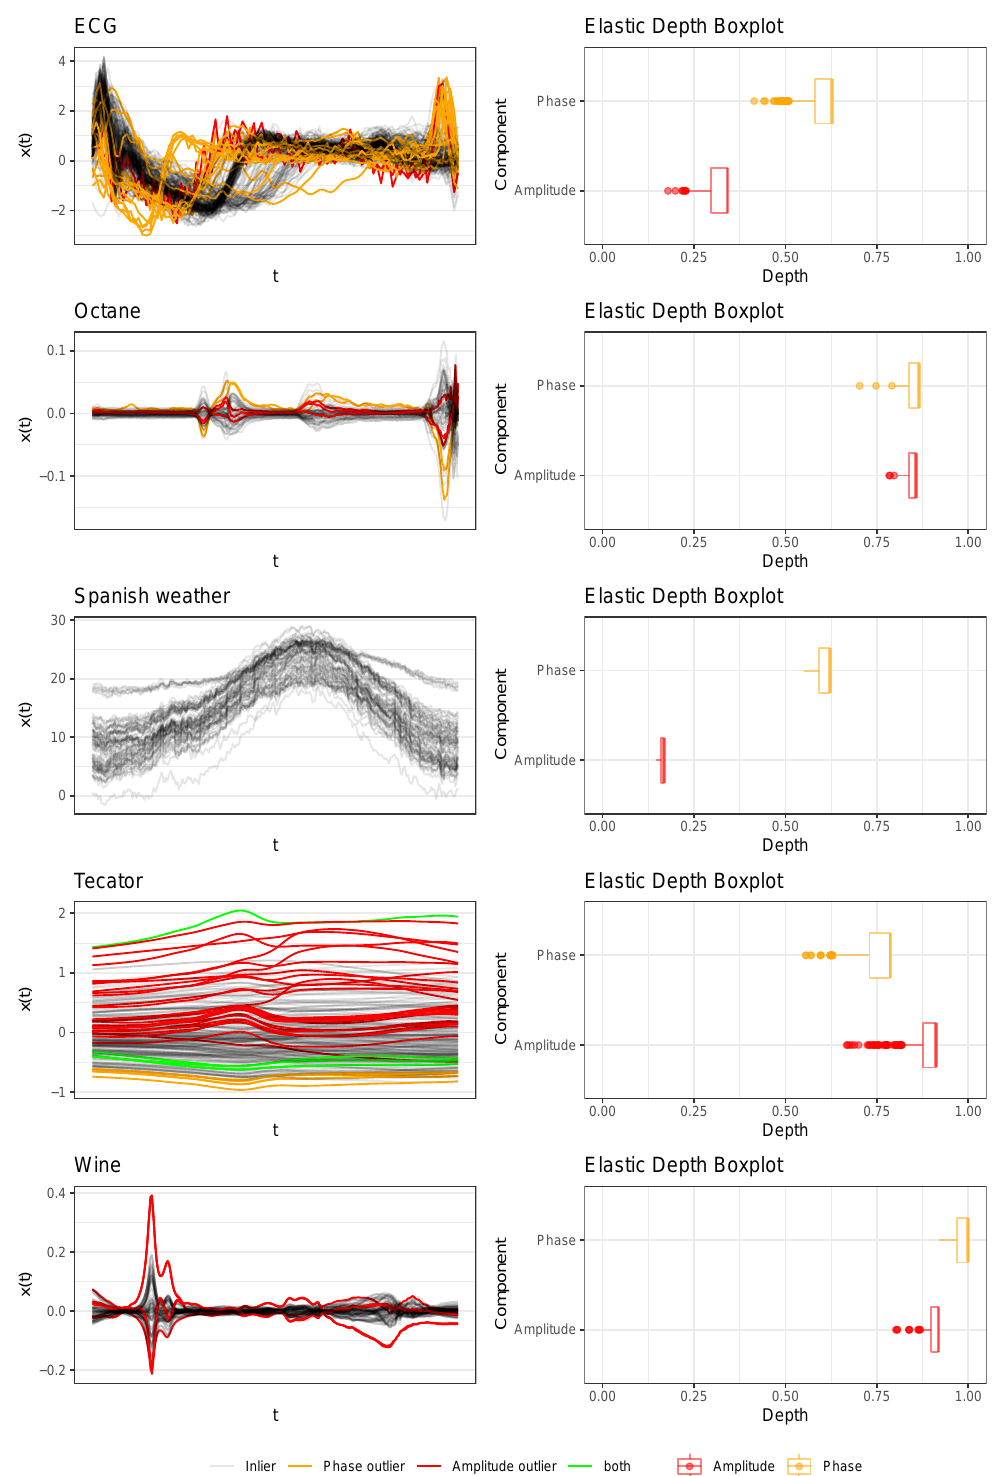
Figure A7. Left column: data; right column: elastic depth boxplots for amplitude and phase variability. Curves in the left column colored according to the outlier status by amplitude outlyingness and phase outlyingness as diagnosed by elasticdepth::elastic_outliers